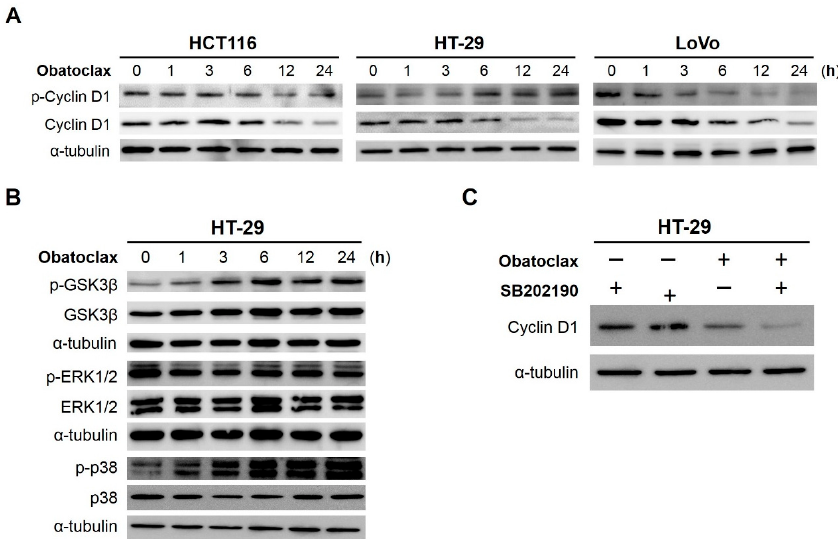
Figure 4. Obatoclax induces T286 phosphorylation-dependent or -independent cyclin D1 degradation. ( A ) Cell line-dependent effect of obatoclax on cyclin D1 T286 phosphorylation. HCT116, HT-29, and LoVo cells were subject to 24 h-treatment with obatoclax (200 nM), followed by immunoblotting to evaluate the levels of threonine 286 (T286)-phosphorylated cyclin D1 (p-Cyclin D1) at indicated time points. α -Tubulin levels served as equal loading control; ( B ) Obatoclax inhibits GSK3 β but activates p38 MAPK , while barely affecting ERK1/2 activity in HT-29 cells. HT-29 cells were exposed to 200 nM of obatoclax for 24 h. The status of activation of GSK3 β , ERK1/2, and p38 MAPK at indicated time points was determined by immunoblotting for corresponding phosphorylation. Specifically, serine 9-phosphorylation of GSK3 β (p-GSK3 β ) reveals inhibition of GSK3 β activity, whereas dual phosphorylation at threonine 202/tyrosine 204 of ERK1/2 (p-ERK1/2) and threonine 180/tyrosine 182 of p38 MAPK (p-p38) indicate activation of ERK1/2 and p38 MAPK , respectively. α -Tubulin levels served as equal loading control; ( C ) p38 MAPK activity is not required for obatoclax-induced cyclin D1 downregulation in HT-29 cells. HT-29 cells were exposed to obatoclax without or with pre-treatment of the p38 MAPK -specific inhibitor SB202190 (10 µM) for 24 h, followed by cyclin D1 immunoblotting. The data revealed that blockade of p38 MAPK activity fails to restore cyclin D1 levels downregulated by obatoclax. GSK3 β (Glycogen Synthase Kinase 3 β ), ERK1/2 (Extracellular Signal–Regulated Kinases 1/2), and p38 MAPK